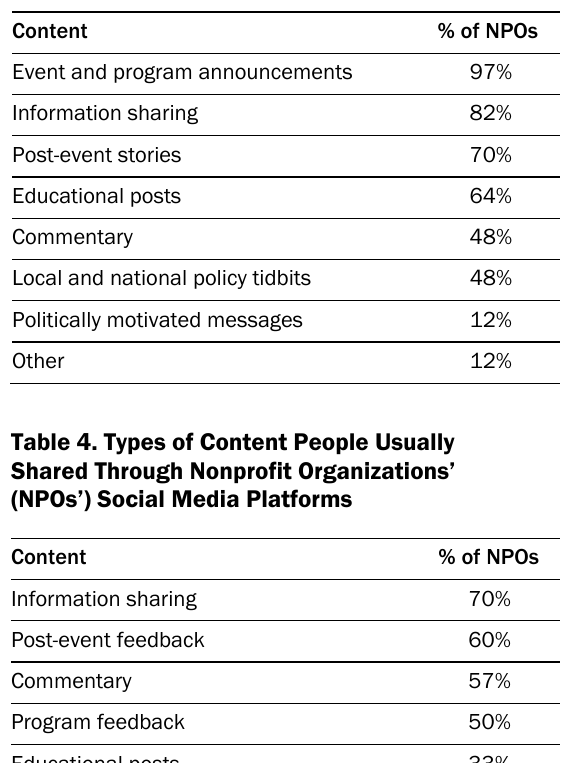
Table 3. Types of Content Nonprofit Organizations